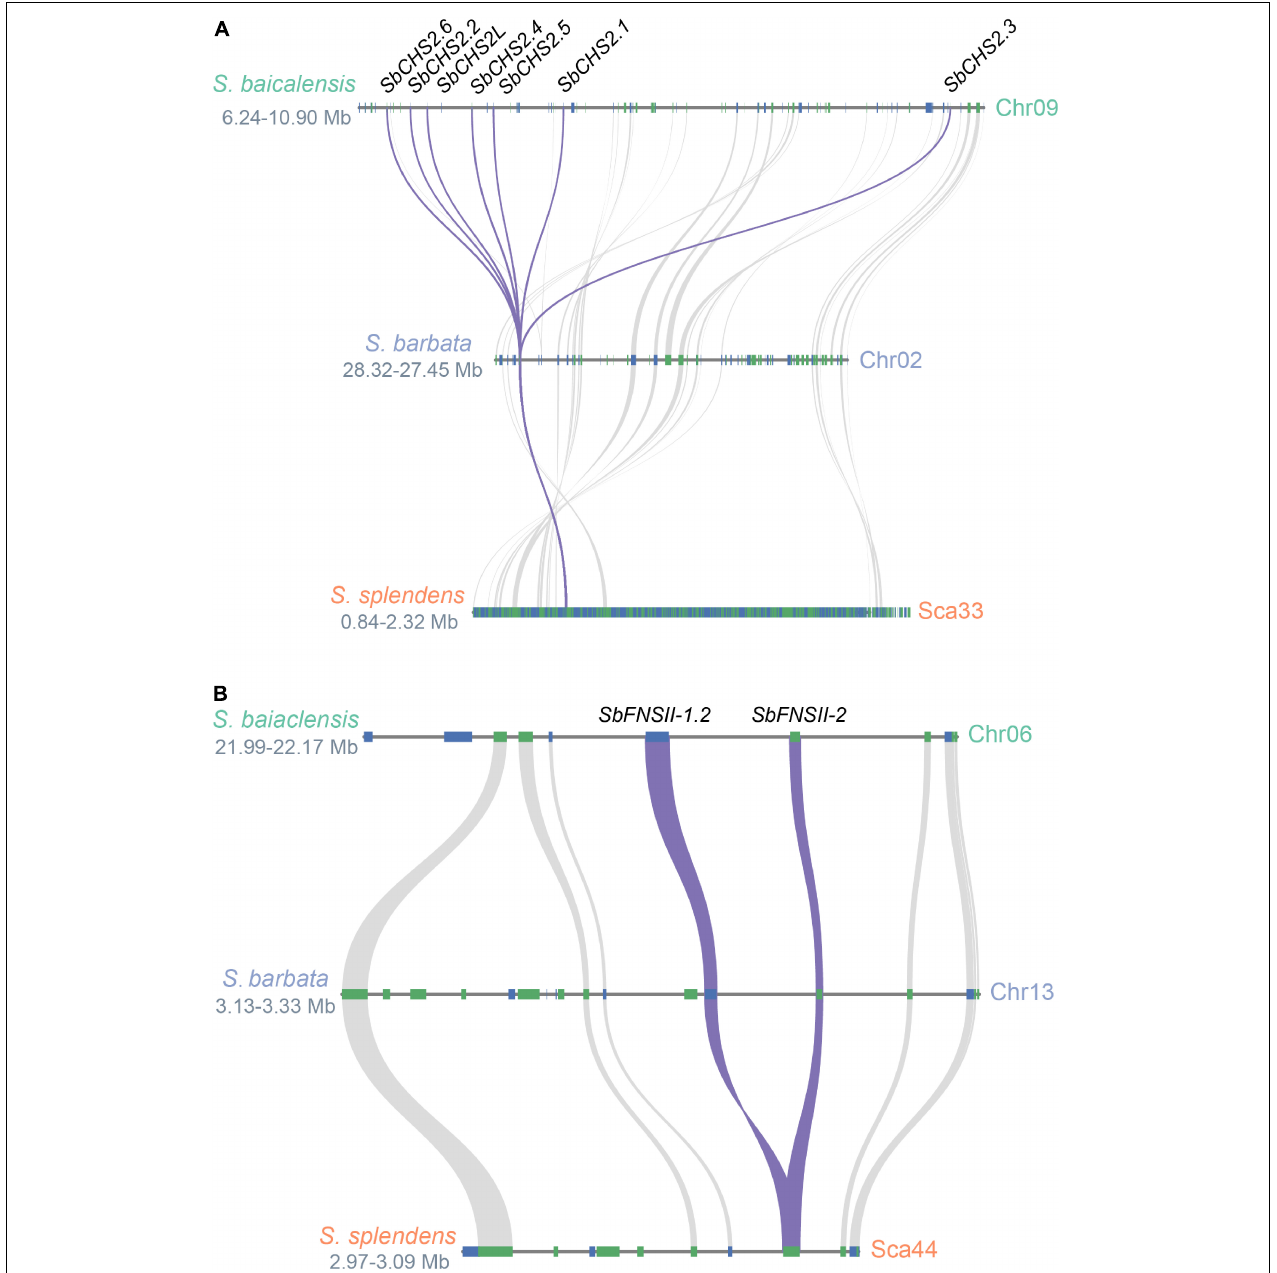
FIGURE 3 | Evolutionary paths of SbCHS2 and SbFNSII-2 . (A) Syntenic analysis of SbCHS2s genes in Scutellaria baicalensis , Scutellaria barbata , and Salvia splendens . The multiplications of SbCHS2 are mostly late at the species level for S. baicalensis . (B) Syntenic analysis of SbFNSII-1 and SbFNSII-2 genes in S. baicalensis , S. barbata , and S. splendens . The duplication of SbFNSII-2 is earlier before the species divergence within Scutellaria .